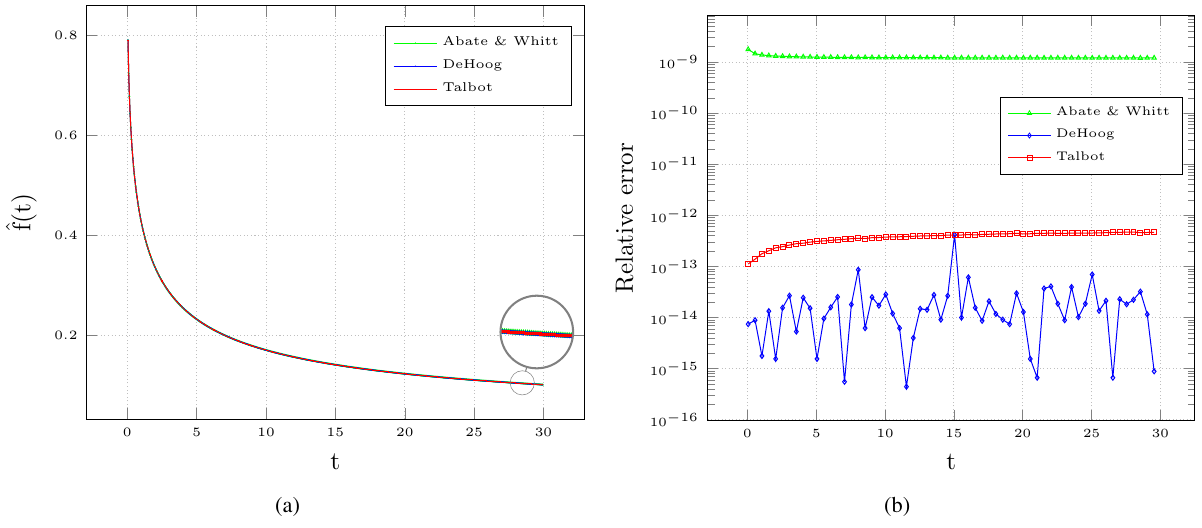
Fig. 6 Plots of numerical inversions ˆ f ( t ) of the Laplace transform (6) (a) and their relative errors (b) for applied methods in interval ( 0 , 30 (cid:105)